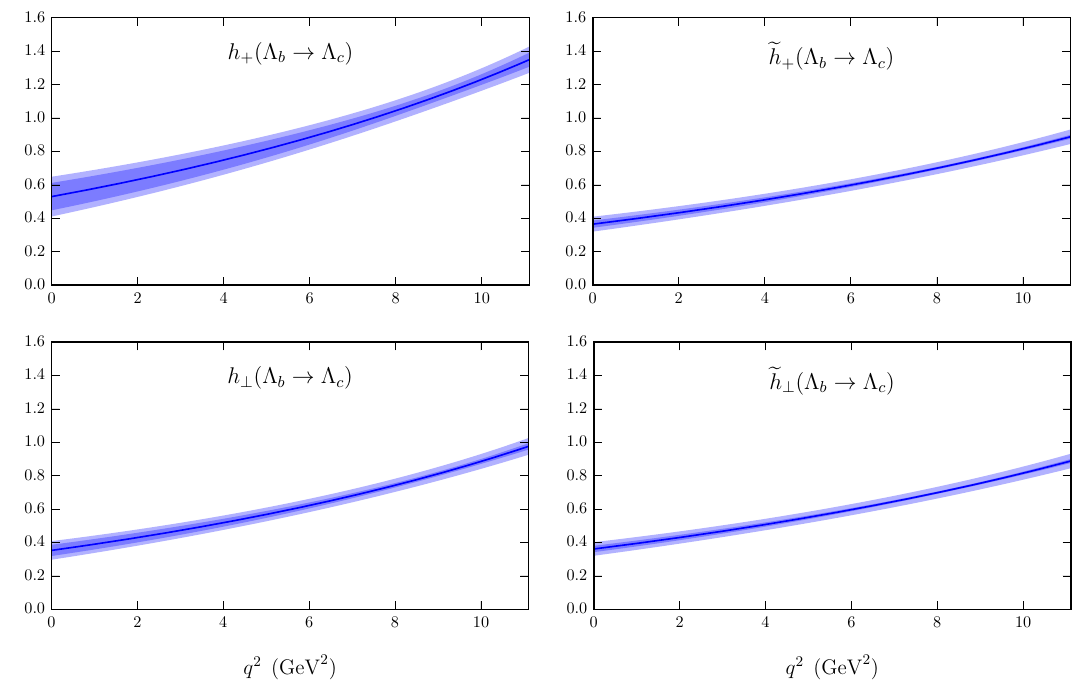
00 0 . Figure 2 . Λ b Λ c tensor form factors in the physical limit, shown in the entire kinematic → range. The form factors are defined in the MS scheme and at µ = m b . The inner bands show the statistical uncertainty and the outer bands show the total (statistical plus systematic) uncertainty. The procedure for evaluating the uncertainties using the nominal and higher-order fits is given in eqs. (82)-(84) of ref.